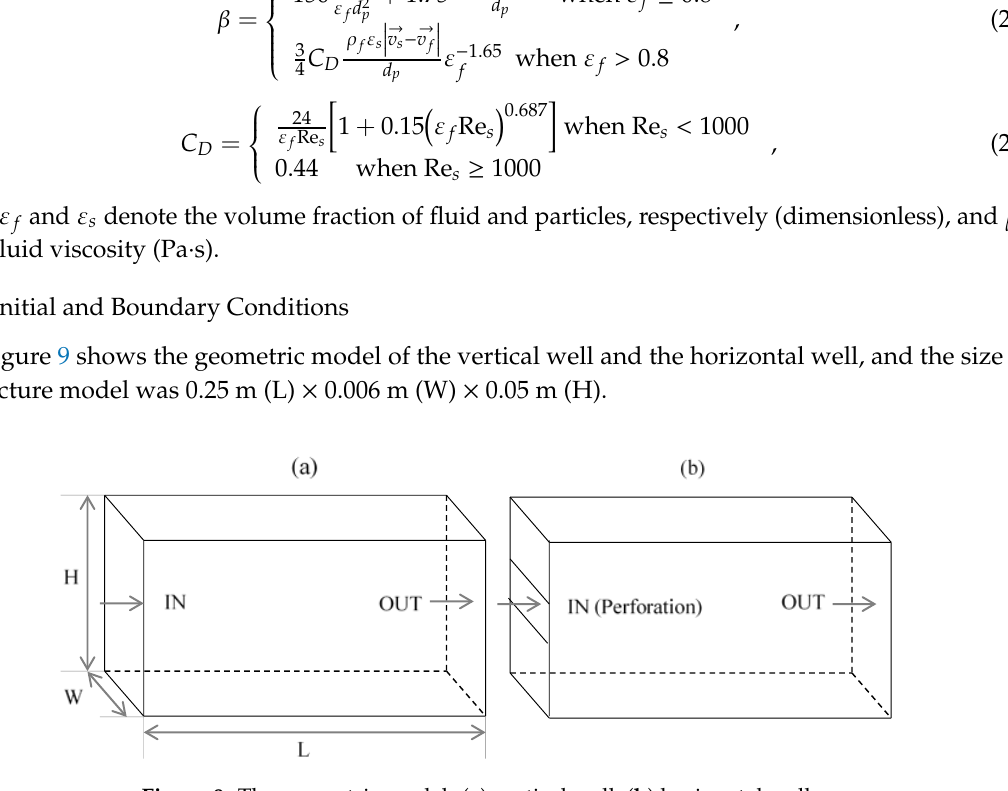
Figure 9. The geometric model: ( a ) vertical well, ( b ) horizontal well.